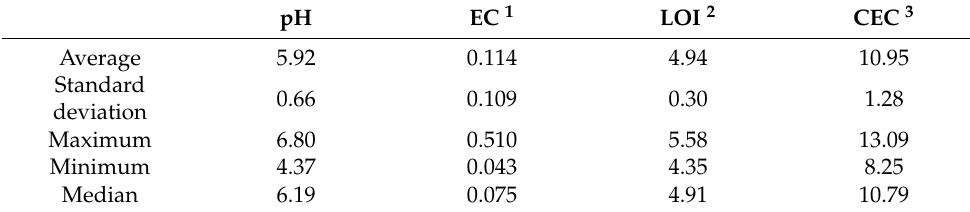
Table 1. Chemical properties of examined soils ( n =